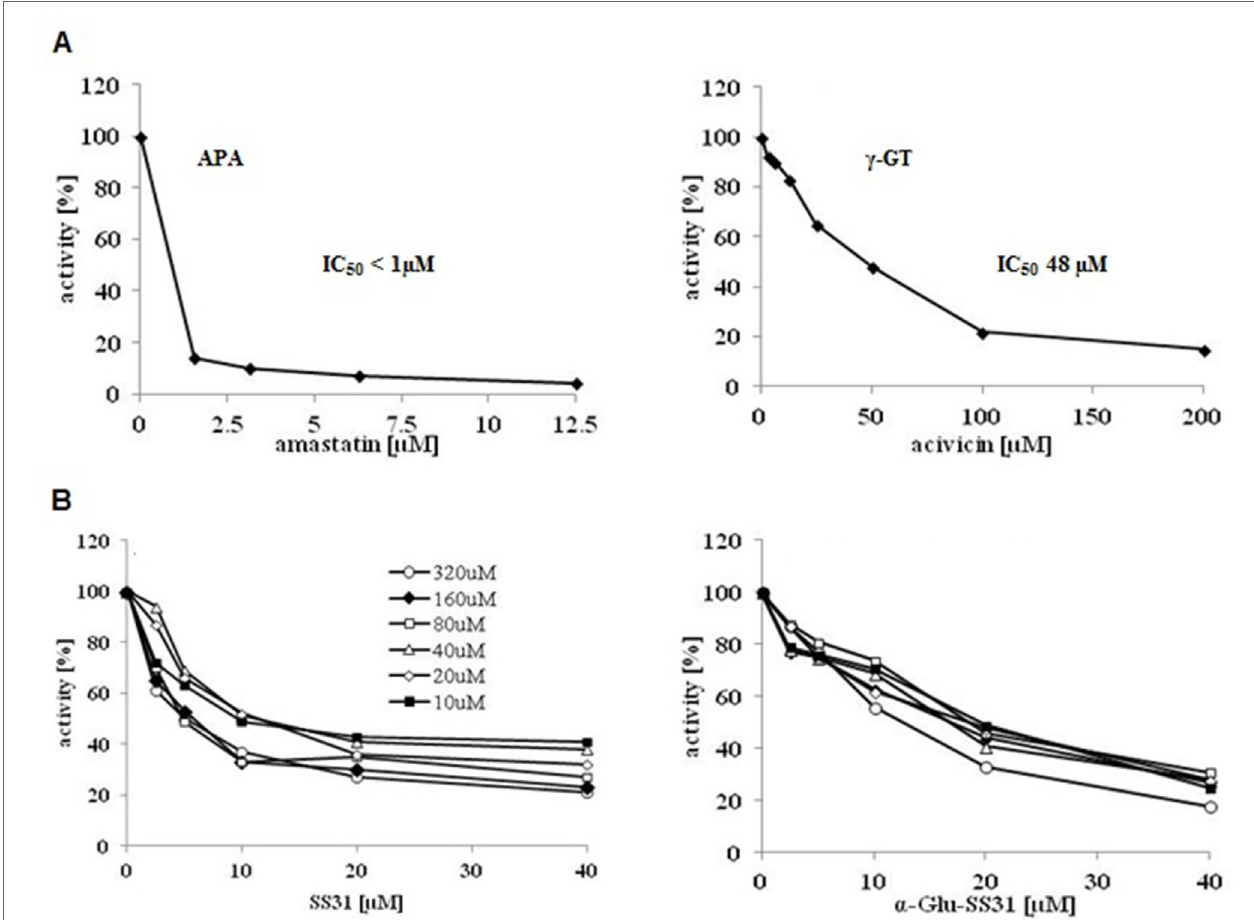
FIGURE 8 | Selective inhibition of the enzymatic activity of aminopeptidase A by SS-31 and its prodrug α -Glu-SS-31 in living EC219 cells. (A) Intact living EC219 cells were exposed to increasing concentrations of either amastatin (left panel) or acivicin (right panel), two well-characterized enzymatic activity inhibitors of APA or γ -GT, respectively. The activities of the enzymes aminopeptidase A (APA) or γ -glutamyltranspeptidase ( γ -GT) were determined using 40 µM of the substrates (S), α -Glu-AMC or γ -Glu-AMC, respectively. (B) Intact living EC219 cells were exposed to increasing concentrations [10-320 µM] of the APA α -Glu-AMC substrate, in the presence of increasing concentrations of SS-31 or α -Glu-SS-31, and the increase of free AMC fluorescence was recorded. Data were analyzed graphically. (DMSO 0.2% was present in all